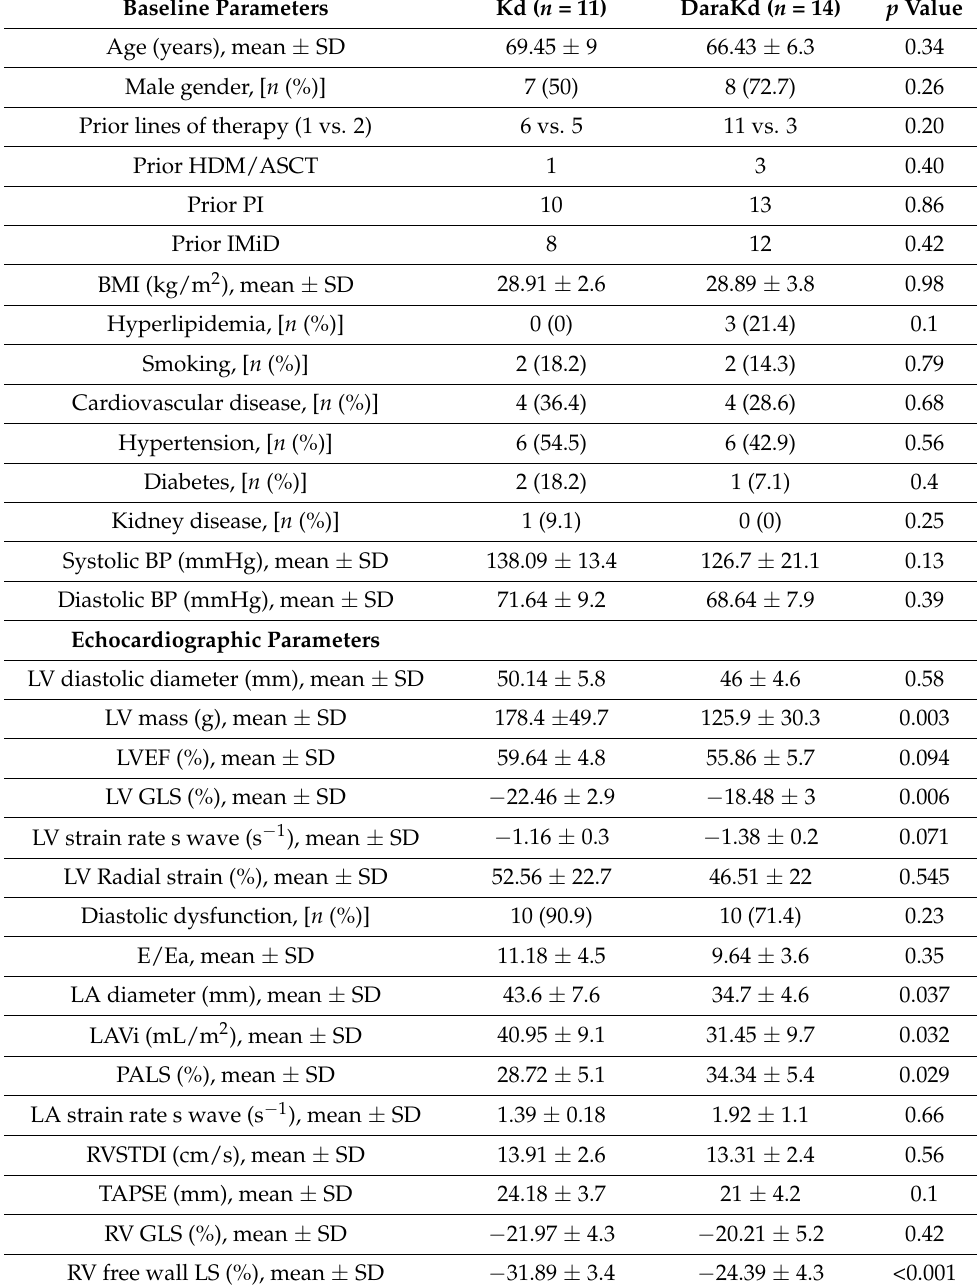
Table 1. Baseline patient